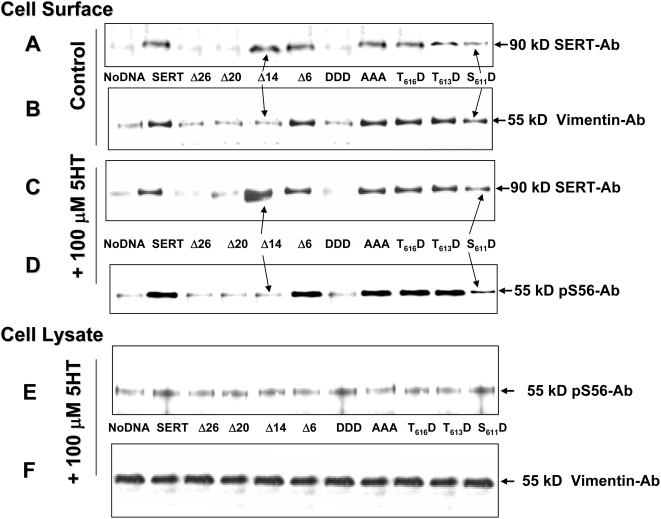
Impact of 5HT stimulation on the plasma membrane density of truncated and mutant transporters.CHO cells expressing truncated or mutant forms of transporter were either directly (A and B) or after stimulated with 100 μM 5HT (C and D) subjected to the cell surface biotinylation assays. Biotinylated membrane proteins were pulled down on streptavidin beads and eluted from the beads in SDS-PAGE sample buffer. The biotinylated eluents were subjected to immunoblot analysis using either anti-SERT (A and C), or anti-vimentin (B), or pS56-Ab (D). All lanes contain protein recovered from the same number of cells equivalent to one of well from a confluent 24-well culture plate. In the surface protein experiments, we included two control experiments: mock biotinylated CHO cells transfected with SERT and mock transfected CHO cells. The first control, mock biotinylated CHO cells, were carried through the biotinylation procedure without the addition of the biotinylation reagent and neither of antibodies, SERT-, vimentin- nor pS56-Abs recognized proteins from these blots (data not presented). The next control, mock-transfected cells allowed us to observe (i) the nonspecific absorption of Sepharose beads and the proteins from the detergent soluble platelet lysate; (ii) if 5HT mediate any of these nonspecific interactions. Pretreatment with 100 μM 5HT increased the density of Δ14 and S611D, significantly or partially, respectively, and decreased the density of wild-type SERT and the truncated or mutant transporters which could to the plasma membrane. The transporters whose surface expressions were decreased with 5HT-stimulation, i.e., wild-type, Δ6, AAA, T616D, and T613D, were able to bind vimentin (B) and phosphovimentin (D). However, the truncated or mutant forms transporters which could not bind vimentin (B) and appeared on the plasma membrane at high levels in 5HT-stimulation (C), such as D14 and S611D, could not bind phosphovimentin (D), either. The total phosphovimentin (E) and vimentin (F) (as flow through of the streptavidin beads) did not differ in truncated and mutant forms of transporter expressing CHO cells. The levels of vimentin and phosphovimentin in cell lysate of 100 mM 5HT-stimulated cells show if the associations between these proteins with SERT or truncated/mutant forms are altered with the differences in their levels, and/or with 5HT stimulation (Figure 7E and F). All lanes contain protein recovered from the same number of cells equivalent to 30% of one well from a confluent 24-well culture plate.